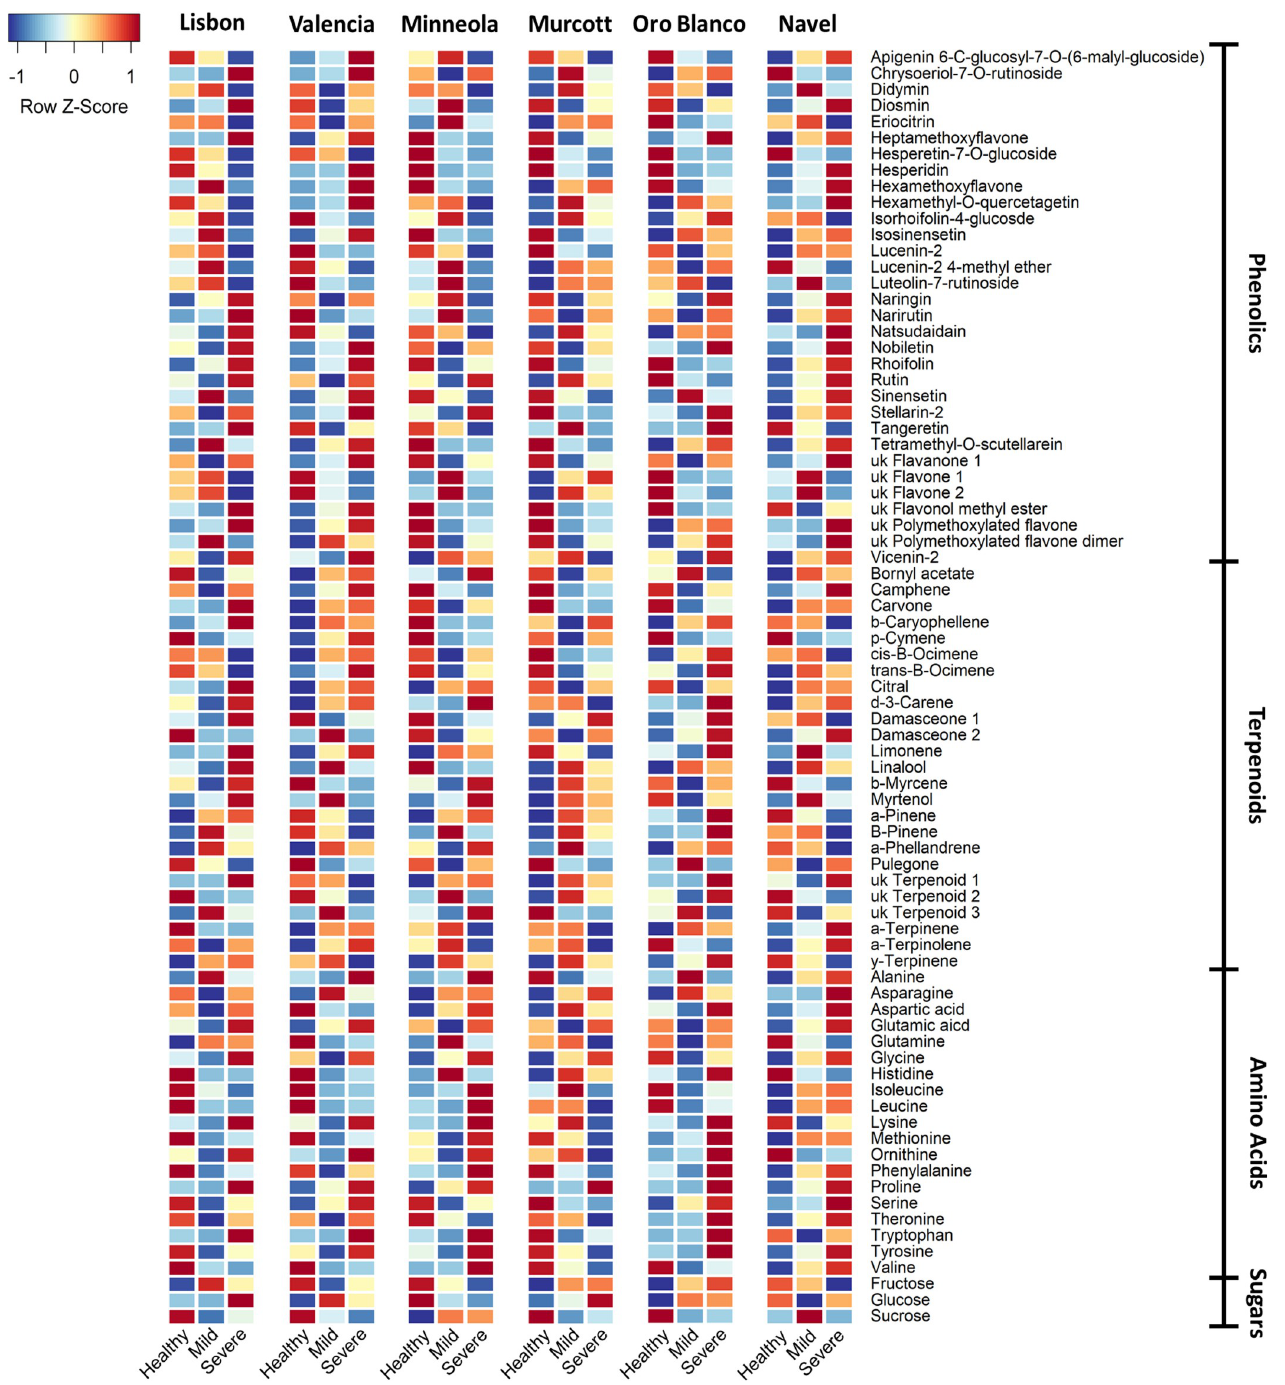
Fig 5. Heatmap of individual compound levels across treatments. Heatmap showing different patterns of individual compound levels for A) phenolics, B) terpenoids, or C) amino acids among cultivars and trees with different infection status. For supporting statistics refer to the ANOVA tables provided in the S1